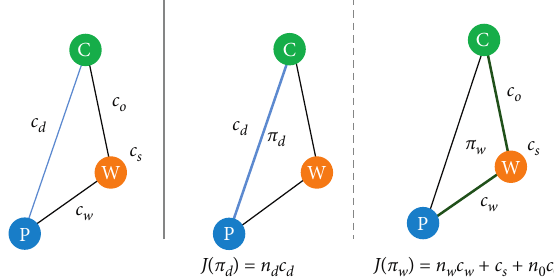
Figure 2: Shipping strategies of a product from a production facility (P) to a customer (C), with an option to use an external warehouse (W). Strategies are associated with freight and storage costs. Costs c d , c w , and c o represent the freight costs associated with the respective labelled transportation links. The cost c s denotes the storage cost of the material in the external warehouse (W). The number n denotes the number of times the shipment is made. Every strategy π is associated with a cost J ( π )